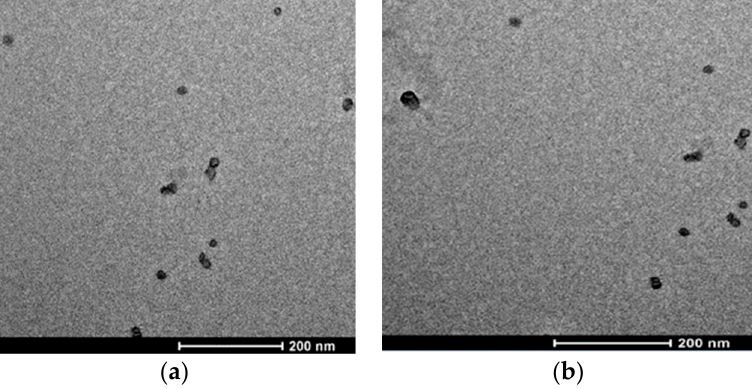
Figure 1. Transmission electron microscopy (TEM) images of ( a ) idebenone loaded solid lipid nanoparticles (SLN); ( b ) idebenone ester with pyroglutamic acid loaded SLN.